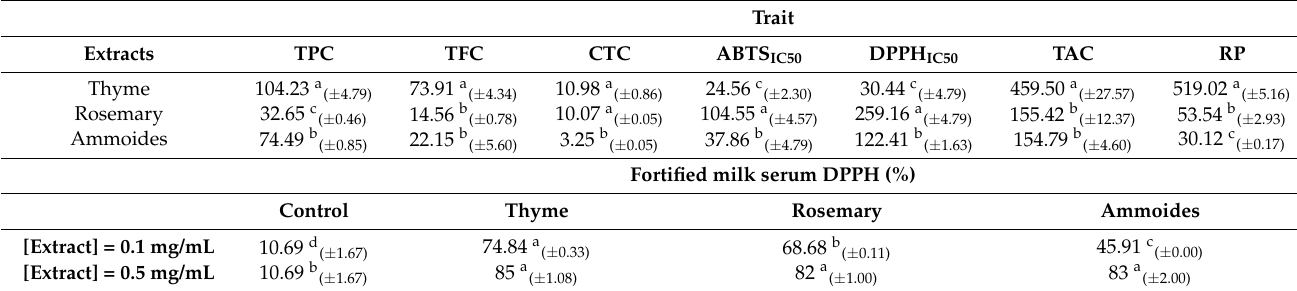
Table 1. Mean phenolic compounds and antioxidant activities of aqueous extracts of thyme, rosemary, and ammoides and antioxidant activity of fortified pasteurized milk serum 1